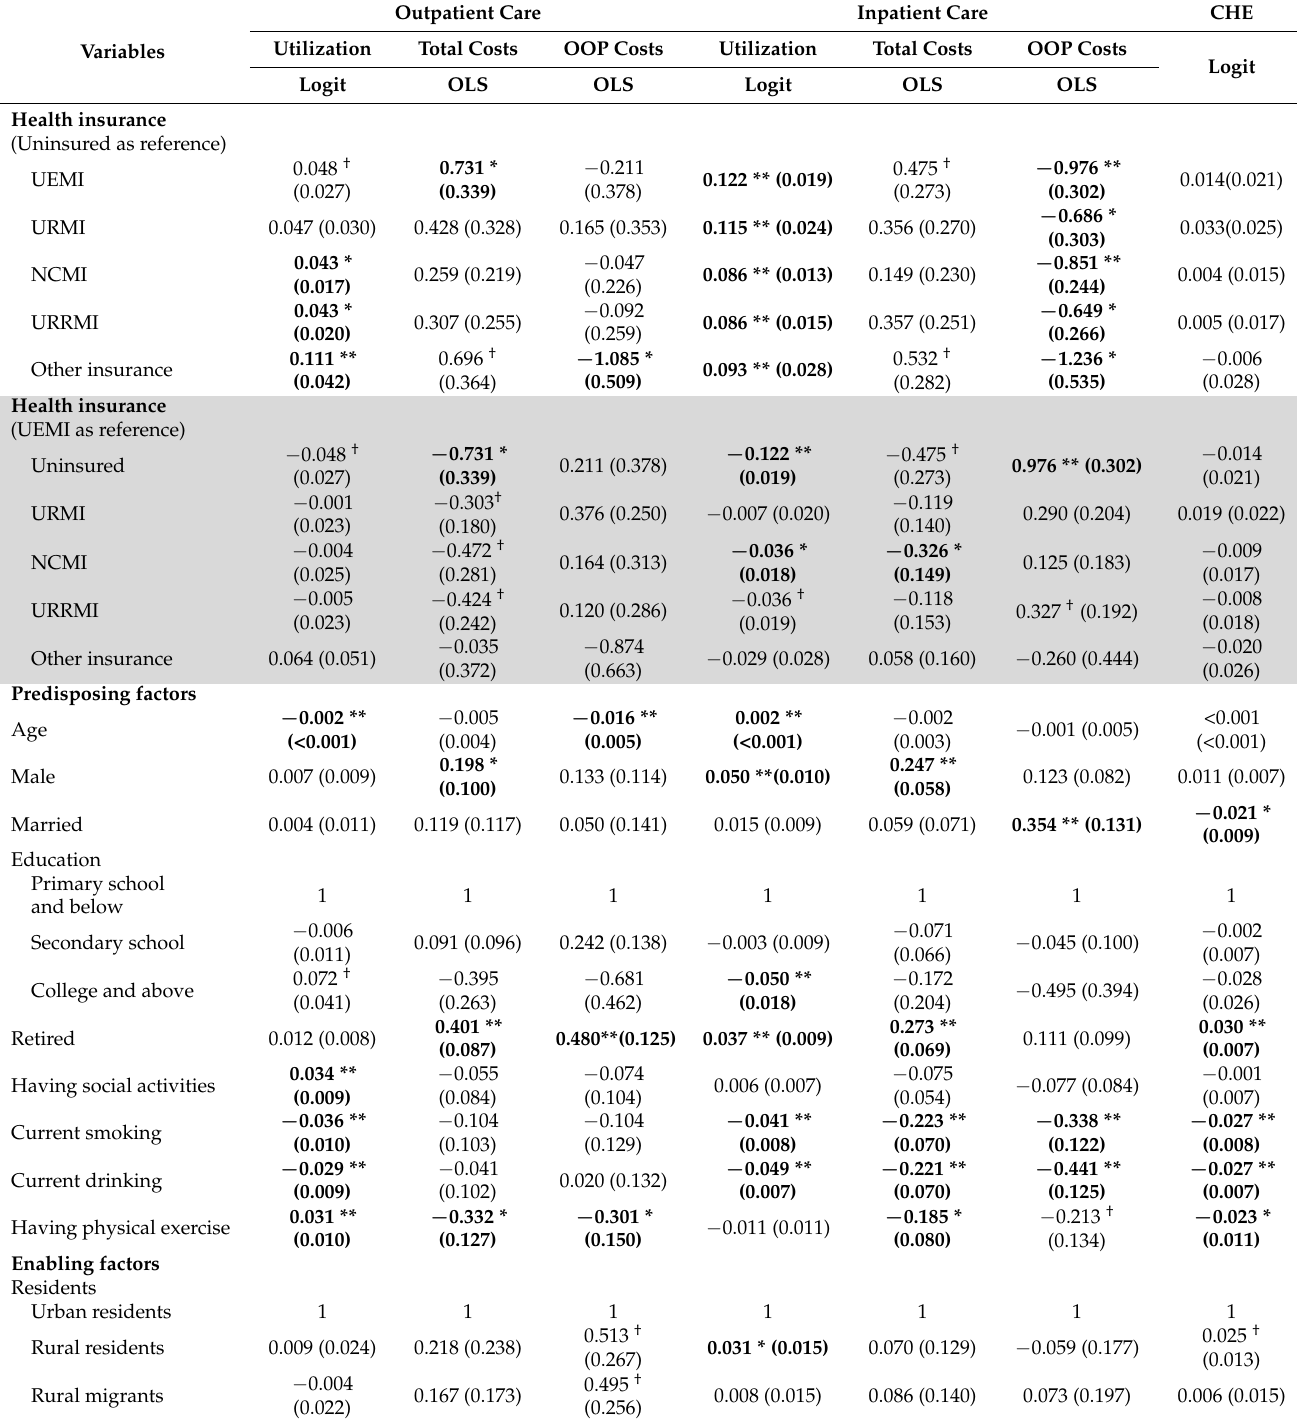
Table A1. Two-part model for health utilization and costs (inpatient and outpatient) and logistic regression for